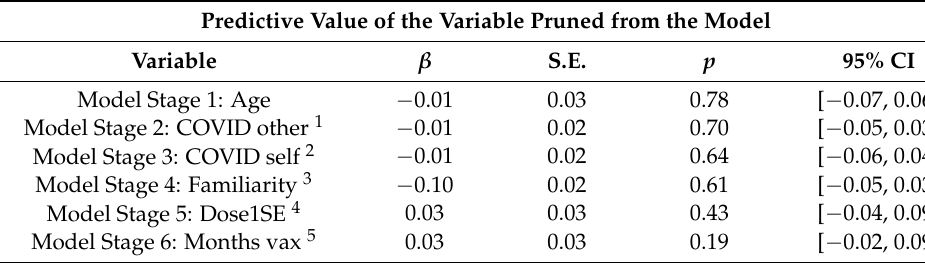
Table 3. Predictors pruned from the model at each stage of model refinement (UK